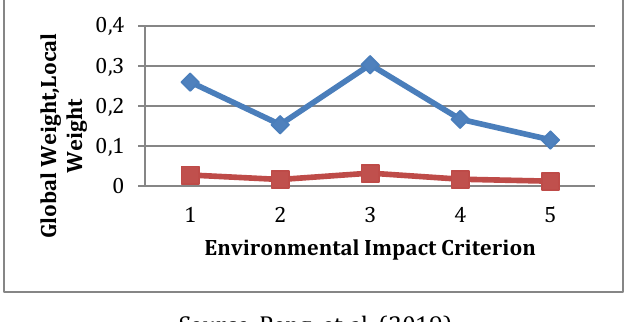
Figure 24: Variation of global and local weights of environmental impact criteria